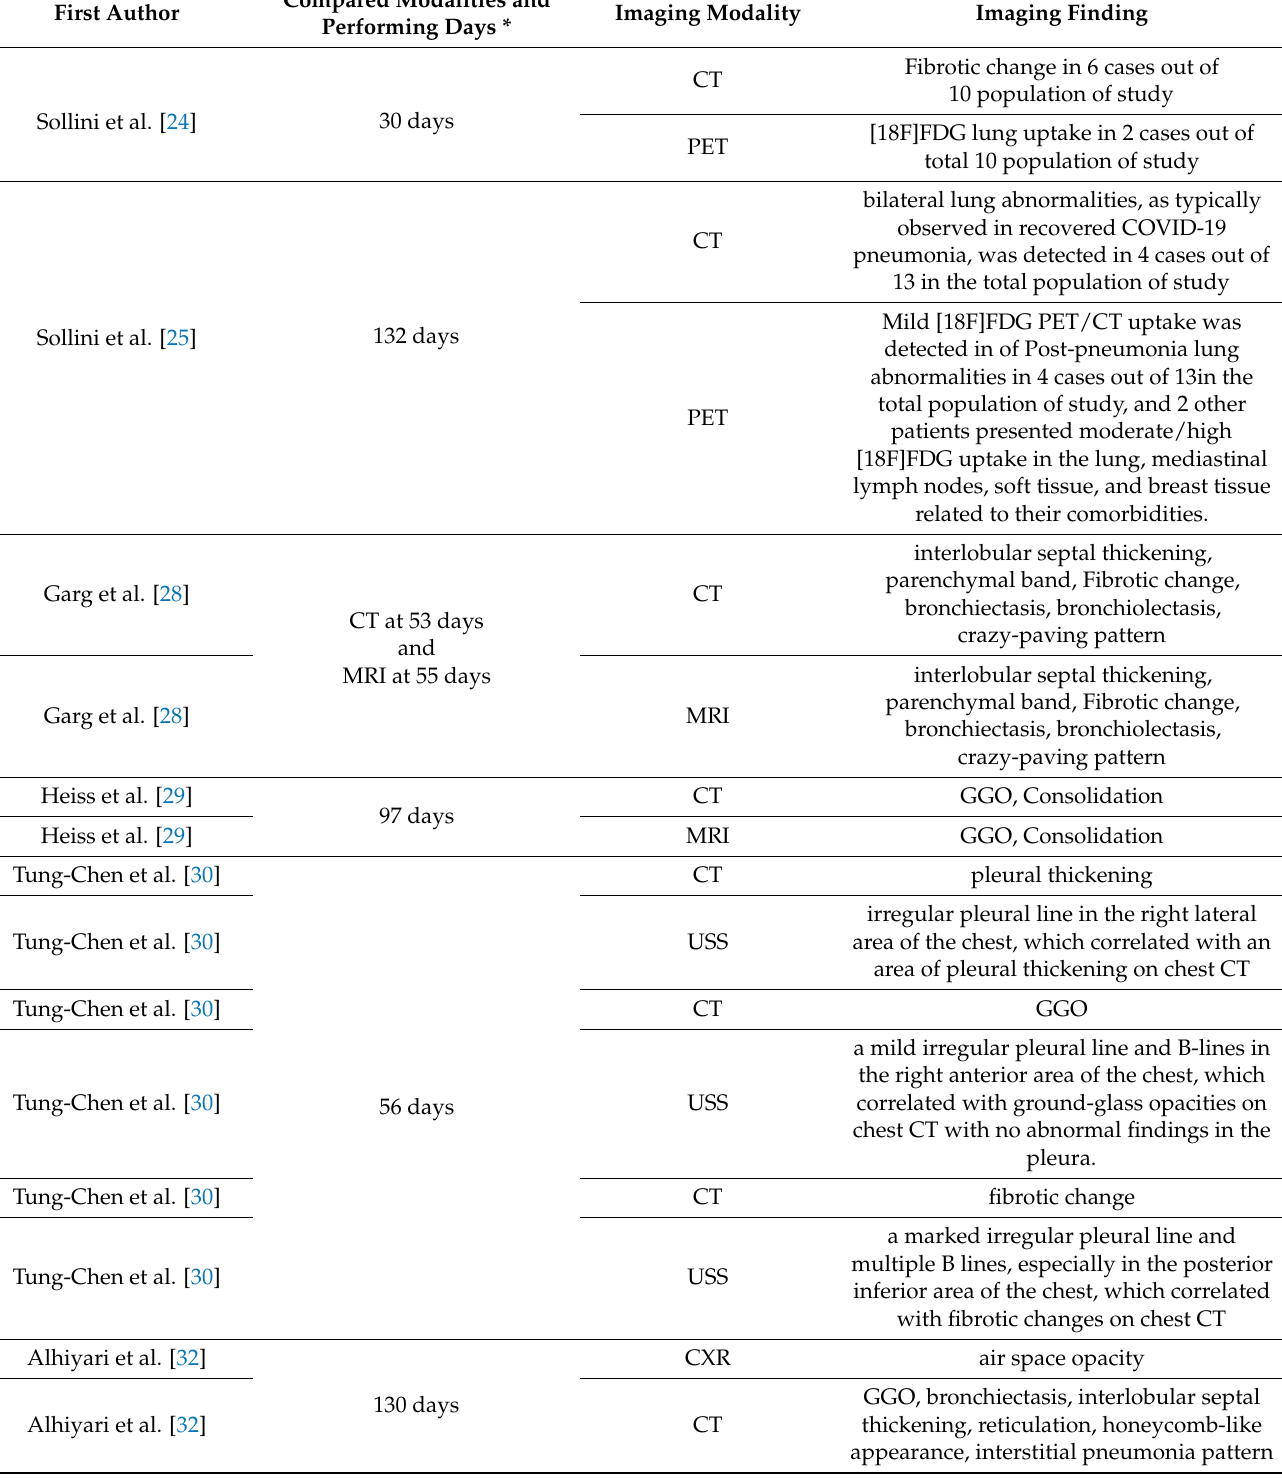
Table 6. Comparison of various imaging